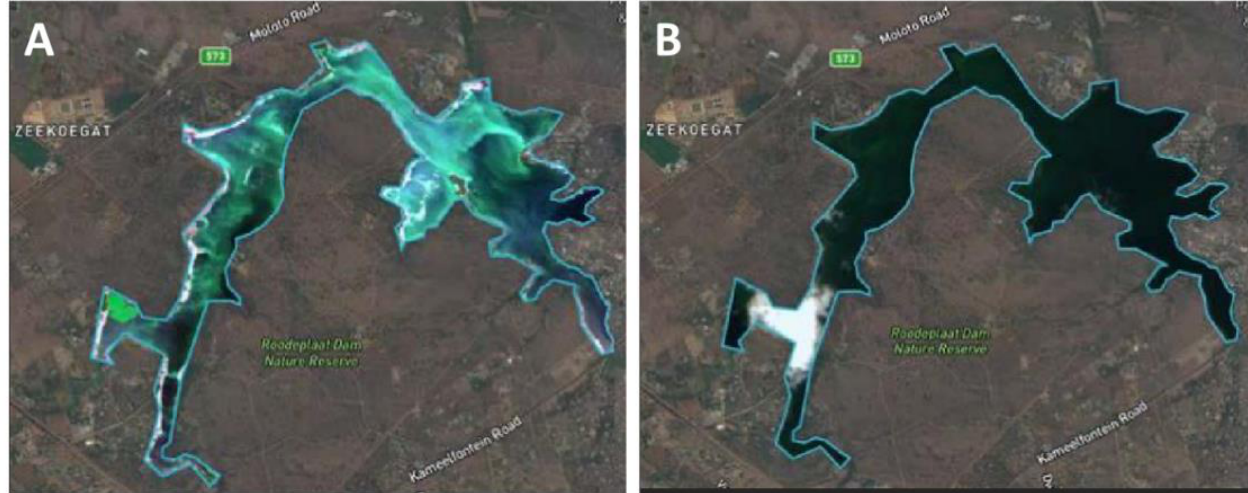
Figure 3. A satellite picture (unprocessed) of Roodeplaat dam area in South Africa ( A ) before and ( B ) 10 days after treatment with a floating composition that releases H 2 O 2 (adapted from https://bgtechs.com/, with permission, accessed date 7 July 2021). A cloud is present in the left side of panel B.